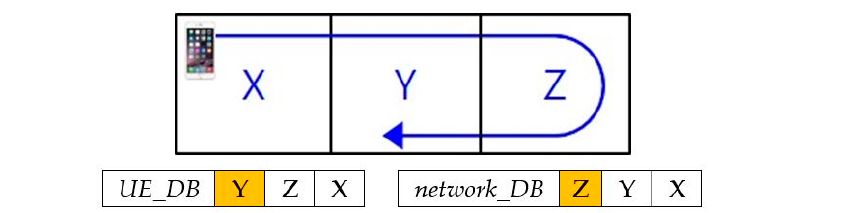
Figure 2. Zone-based registration with three zones.